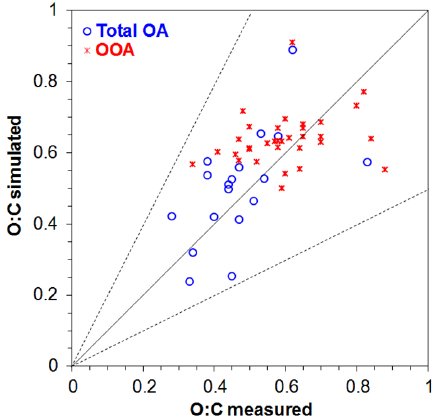
Figure 9. Scatterplot comparing model predictions to measure- ments for O:C ratio of total OA (in blue) and OOA (in red) over nonurban areas in the Northern Hemisphere during 2001–2010. Each point represents the dataset average value over a specific mea- surement site. Also shown are the 1 : 1, 2 : 1, and 1 : 2